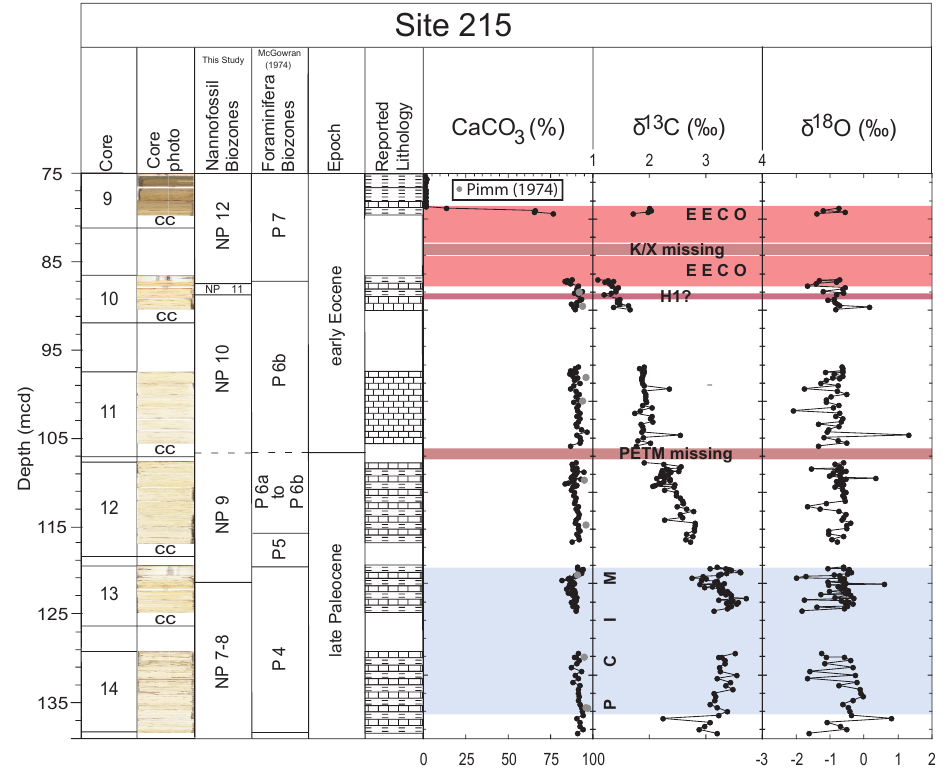
Figure 9. Early Paleogene sequences at DSDP Site 215. Biostratigraphy and lithology have been modified from the DSDP Leg 22 volume (von der Borch and Sclater, 1974). Core photos are sourced from the online database (www.iodp.org). Carbonate content records include data from previous work (grey – Pimm, 1974). Enriched δ 13 C and biozonations enabled the identification of the PCIM in cores 14–13. Calcareous nannofossil NP biozones from Martini (1971) and foraminiferal P biozones from Berggren et al. (1995). The PETM is in the core gap between cores 12 and 11, consistent with the presence of the P5 foraminiferal biozone. The H events are either in the core gap between cores 11 and 10 or represented by δ 13 C drop from 88.787 to 88.29mcd. The NP11 and NP12 biozones and depleted δ 13 C enabled the EECO identification in upper portion of core 10. The K/X event is in the core gap between cores 10 and 9. Note lithological facies key in Fig.